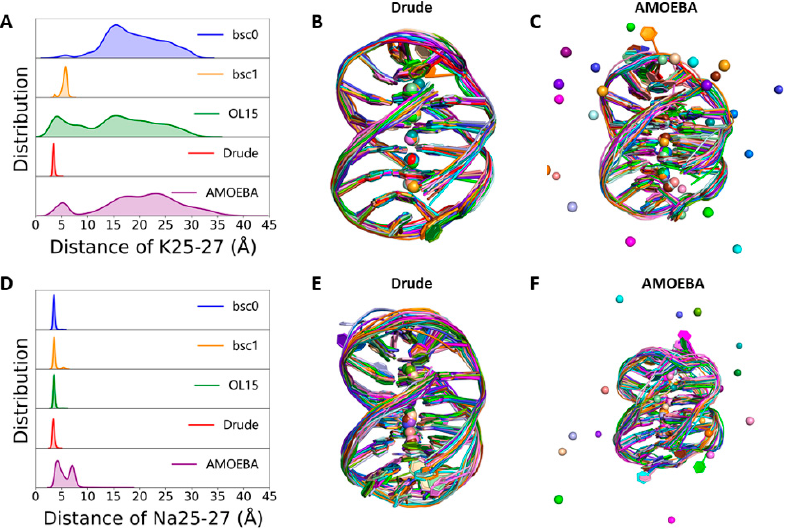
Figure 3. The distribution of distances between terminal ions and the comparison of experimental and simulated structures of GQ in replication 1. ( A ) and ( D ) are the distribution of distance be ‐ tween K25–K27 in K ‐ GQ and Na25 ‐ Na27 in Na ‐ GQ in MD simulations, respectively. ( B )–( F ) are alignments of experimental structures of K ‐ GQ and Na ‐ GQ with that were taken from MD simula ‐